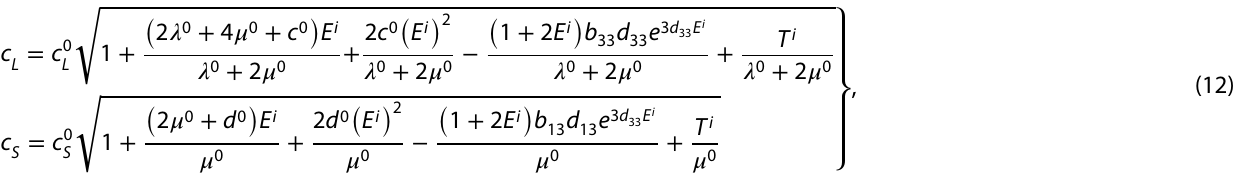
Table 2 Ultrasonic-wave velocities of three rock samples subjected to the hydrostatic pressure from 0 to 400 MPa shown in Table 4 of Pros et al.